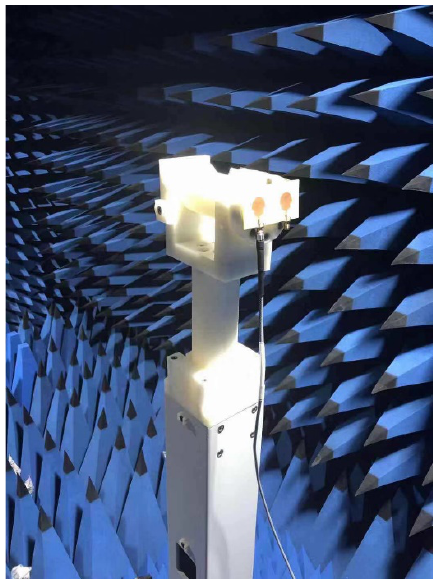
Fig. 9. Far-field measurement